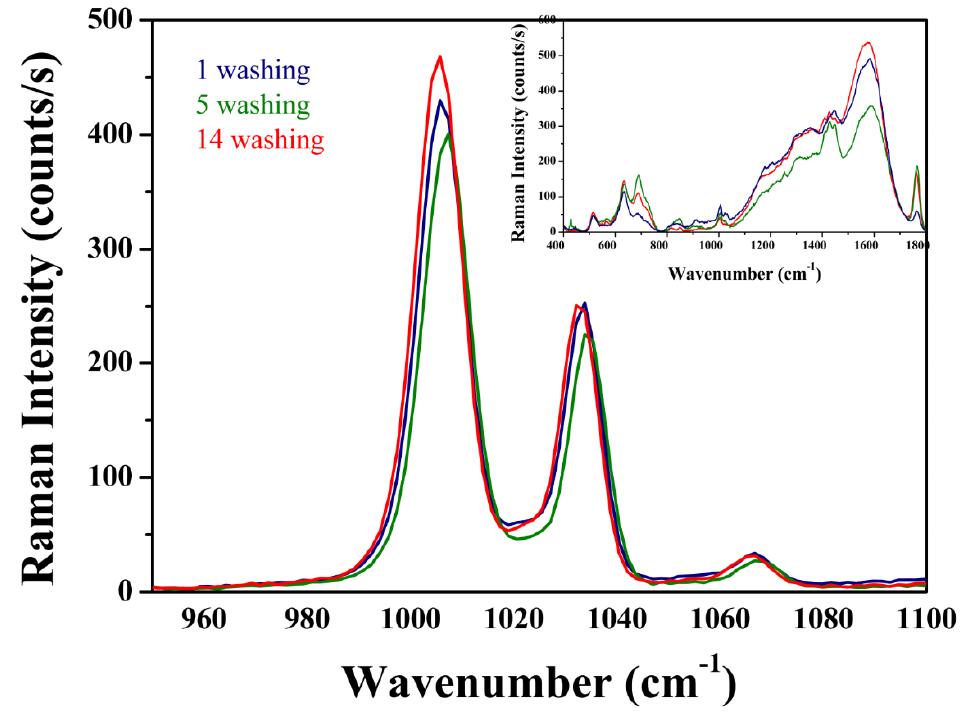
Figure 15. SERS spectra for Ag CNP S deposited on TiO 2 nanotubes with pyridine and without pyridine (insert) after 14 cycles of water washing.